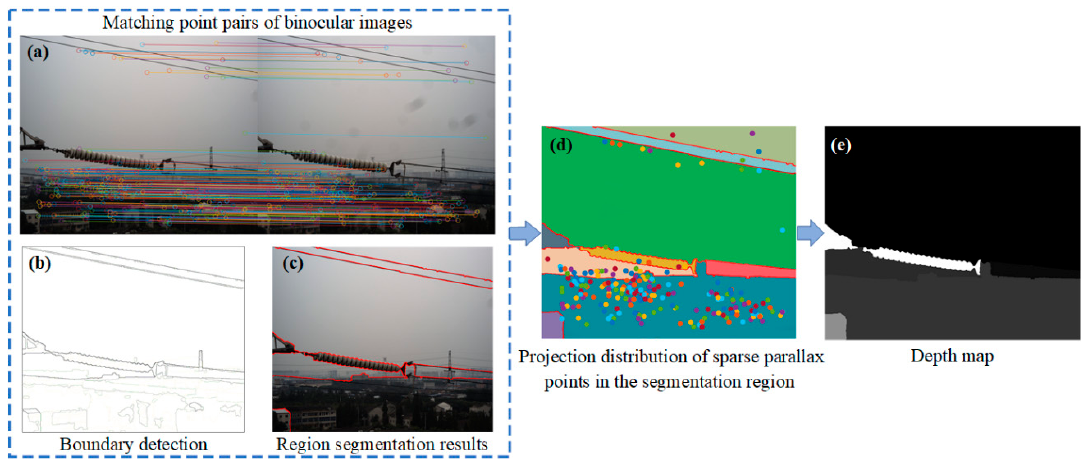
Figure 4. Schematic of depth map construction: ( a ) image matching result; ( b ) boundary detection; ( c ) region segmentation result; ( d ) projection distribution of sparse parallax points in the segmentation region; ( e ) depth map.